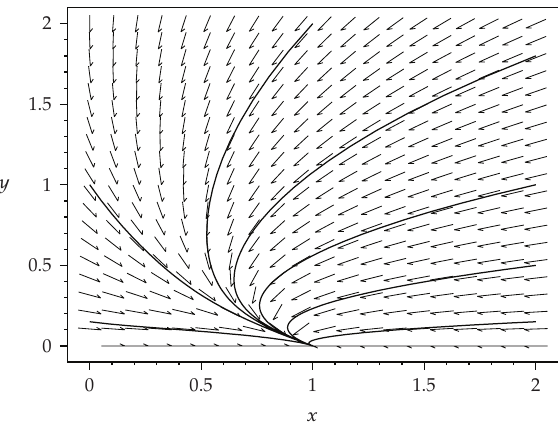
Figure 1: Topological structure of system (cid:5) 3.1 (cid:6) at (cid:5) b/d, 0 (cid:6) when R 0 < 1, where b (cid:7) 1 , d (cid:7) 1 , k (cid:7) 1 , γ (cid:7) 1 , α (cid:7) 1 , μ (cid:7) 1.